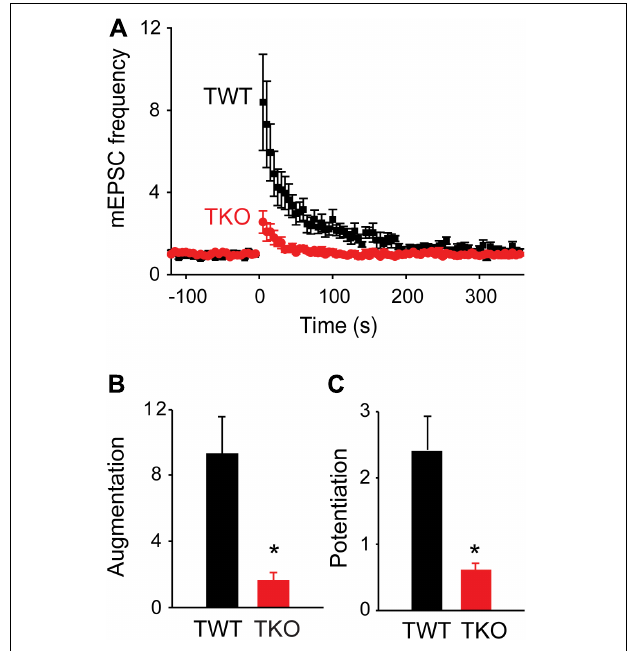
FIGURE 2 | Role of synapsins in augmentation and potentiation. (A) Time course of changes in normalized mEPSC frequency produced by electrical activity (50 Hz, 2 s stimulation) in TWT (black) and TKO (red) neurons. Points indicate mean values of mEPSC frequency ( n = 7), normalized to baseline values measured prior to the stimulus train, and error bars indicate ± SEM. (B) Peak amount of augmentation of mEPSC frequency, calculated from exponential fits to the data in panel (A) , in TWT (black) and TKO (red) neurons. (C) Amount of potentiation of mEPSC frequency in TWT (black) and TKO (red) neurons. Values in panles (B,C) indicate means and error bars indicate ± SEM, while asterisks indicate significant differences ( p < 0.05) between TWO and